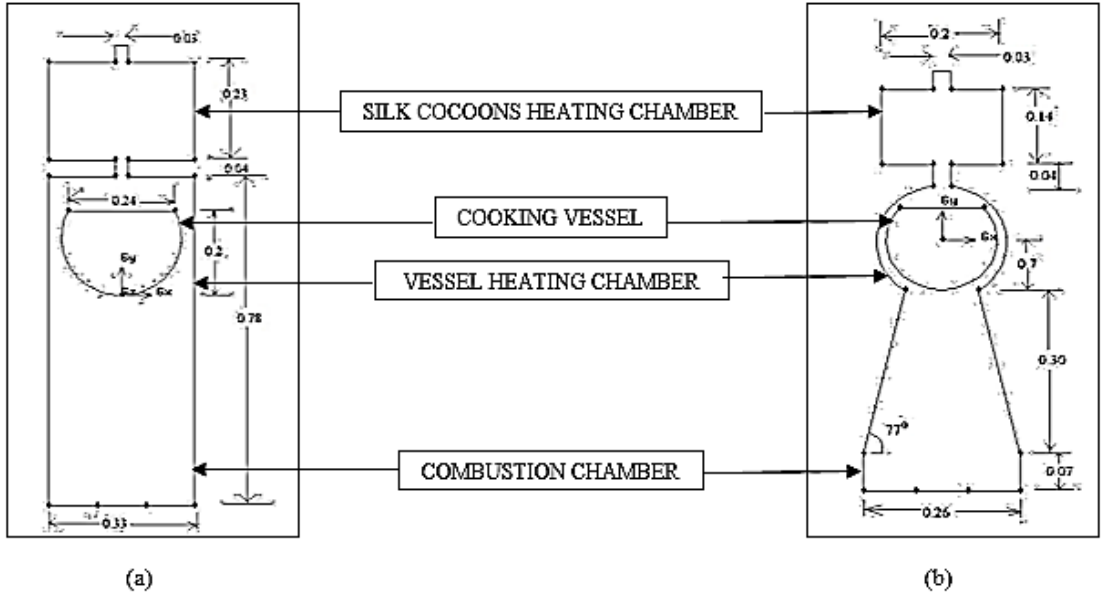
Figure 2. Schematic diagram of (a) system having spherical boiling chamber and channel type combustion chamber and (b) system having spherical chamber and nozzle type combustion